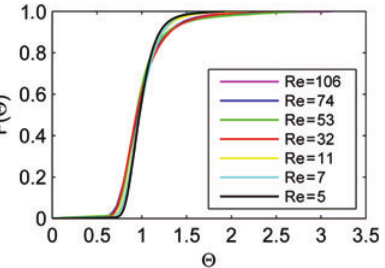
Figure 8 Flow scheme for the analysis of the residence time distri- bution and the resulting F( θ ) curves for the μ -CaR. Conditions: Ocean